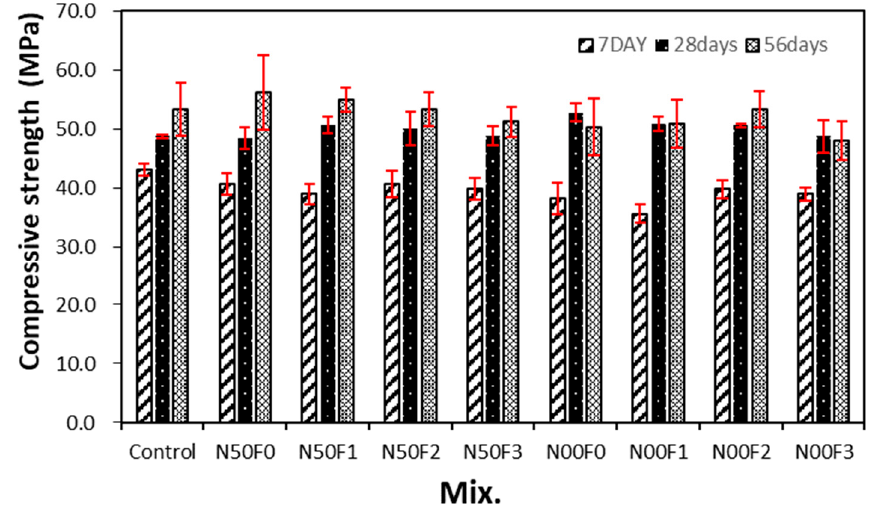
Figure 6. Compressive strength of different mixture samples.